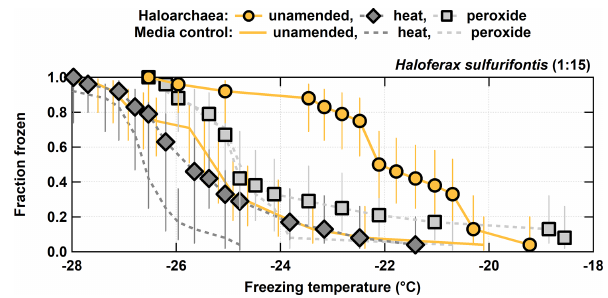
Figure 3. Unamended, heat labile (heat), and organic (peroxide) frozen fractions for each of the 1 : 15 diluted H. sulfurifontis from the processing treatments. H. walsbyi and N. pharaonis are not shown since they exhibited no INP activity in their unamended spec- tra. Error bars indicate 95% confidence